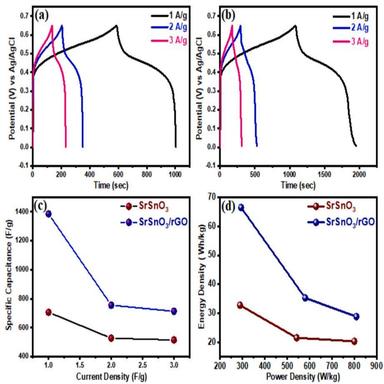
(a) GCD of SrSnO3 (b) GCD of SrSnO3/rGO nanohybrid and (c) Plot of energy density vs specific capacitance (d) power density vs energy density plot.